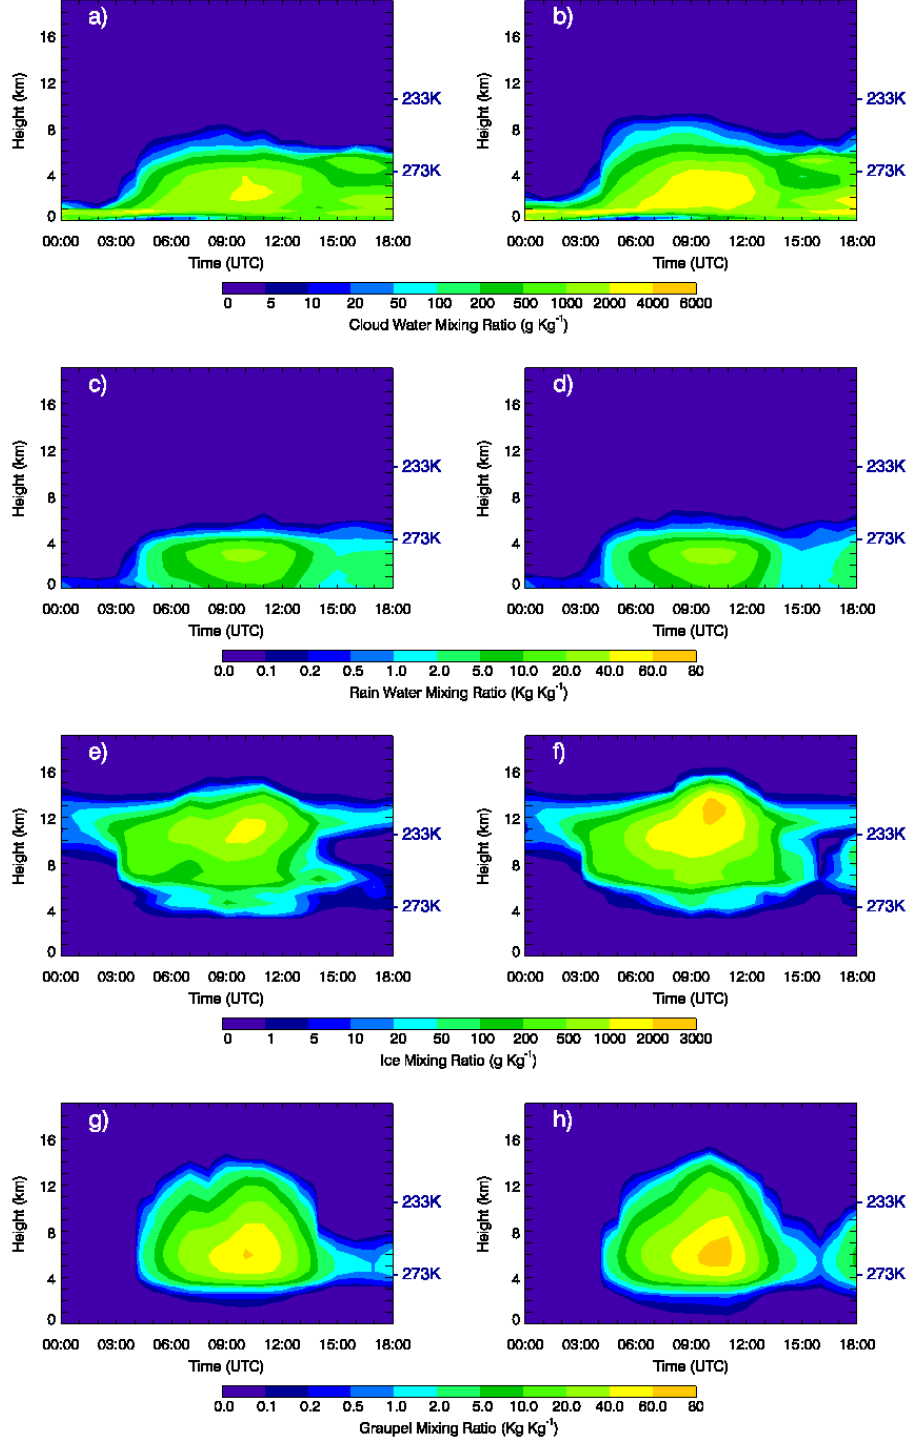
Figure 13. Fig. 13. Temporal evolution of the horizontally domain-summated mass mixing ratio of (a) cloud water in the C-case, (b) cloud water